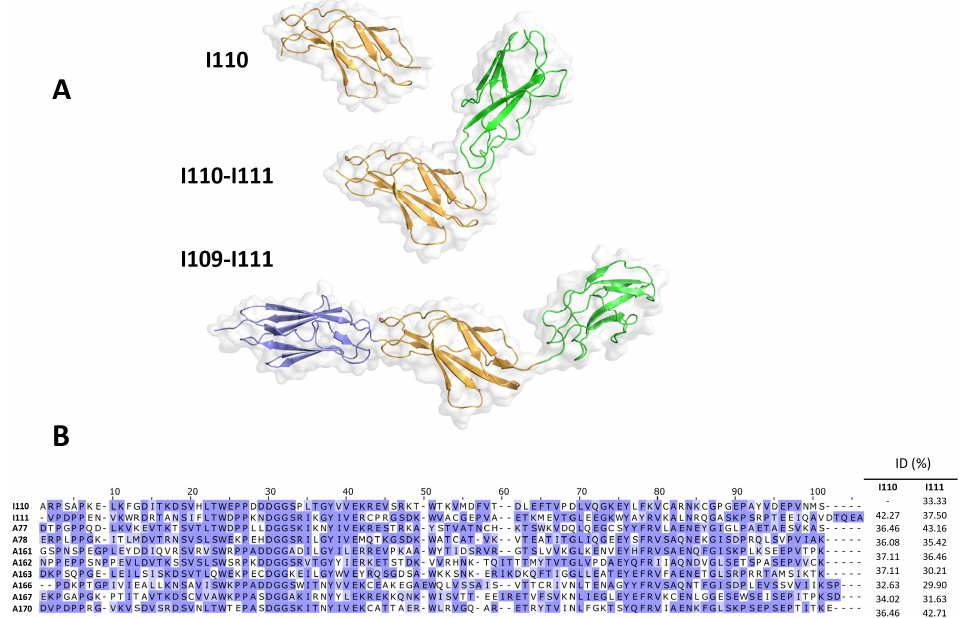
Figure 7. Crystal structures of the MIR I109-I111 tandem and its subcomponents. ( A ) Crystal structures where individual domains are color-coded across structures. All structures have been positioned as to agree in their orientation of the I110 domain (orange); ( B ) Conservation across I110 and fibronectin domains are used as negative controls in this study. Domains A77-A78 of known crystal structure are included as used in structural comparison. Conservation is color-coded ac- cording to BLOSUM62 and sequence identities across domains is provided (right). Non-conserved residues in I110 might form part of a potential epitope site.